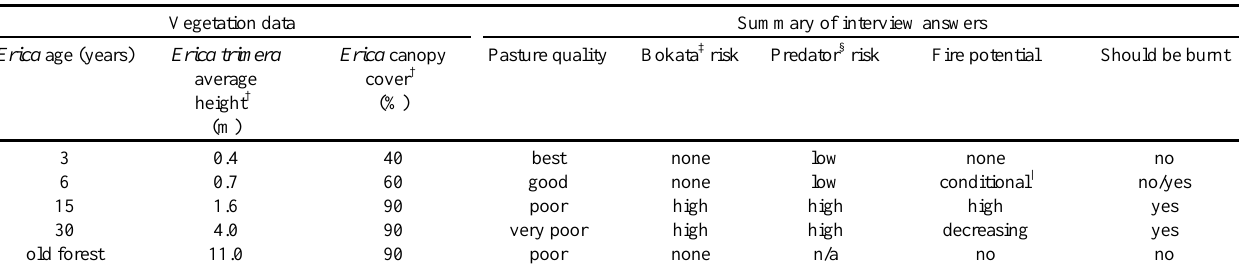
† Erica height and canopy cover in relation to age refer to the upper limit for each class and are taken from the vegetation survey (Fig. 10) and unpublished data for older stages. ‡ Bokata is the local name for the stinging moth caterpillar. § Large predators: hyena, leopard, and lion | Can burn only with strong wind or steep slope